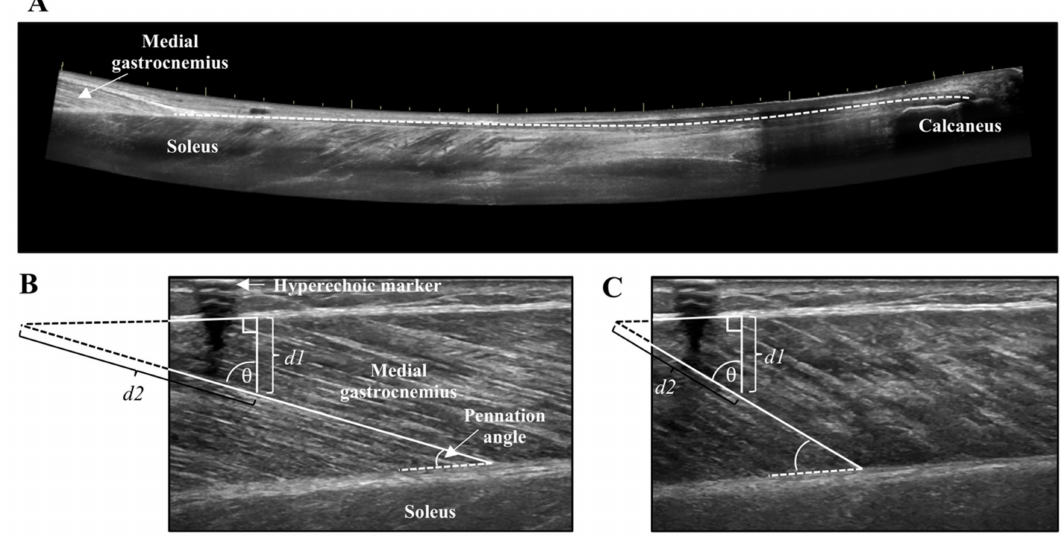
Figure 2. ( A ) LOGIQView ® scan of the Achilles tendon showing the length measurement from the calcaneus to the muscle-tendon junction of the medial gastrocnemius. ( B ) Resting and ( C ) contracted medial gastrocnemius fascicle length measurement with extrapolation. Extrapolated portions (d2) were estimated as d 1 / cos θ